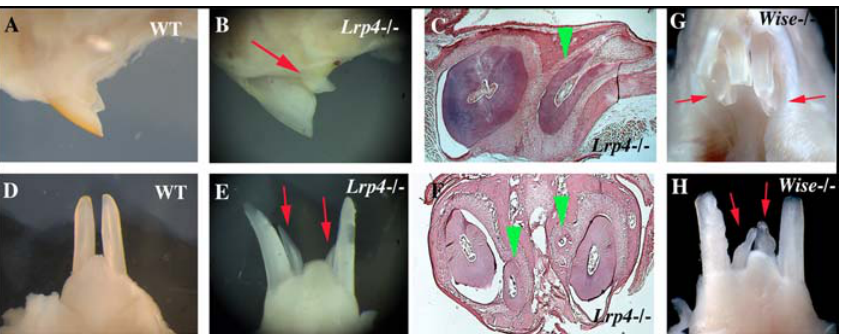
Figure 3. Supernumerary teeth in incisor region. Supernumerary teeth were observed in incisor region on both maxilla (arrows in B, G and arrowheads in C) and mandible (arrows in E, H and arrowheads in F) of both Lrp4 and Wise mutants. Sagittal view of maxillary incisor region (A and B), lingual view of mandibular incisors (D, E and H), occlusal view of maxillary incisors (G), sagittal sections (C) and frontal sections (F) of wild-type (A, D), Lrp4 mutants (B, C, E, F) and Wise mutants (G, H) at